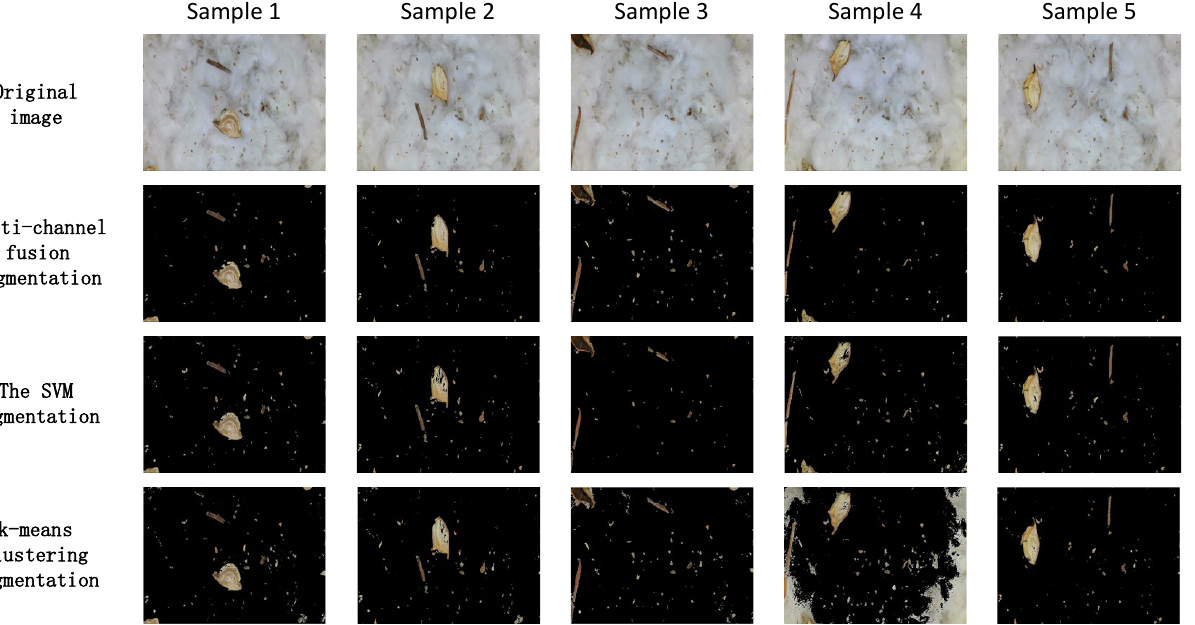
Figure 11. Segmentation effect diagrams of the three segmentation methods.